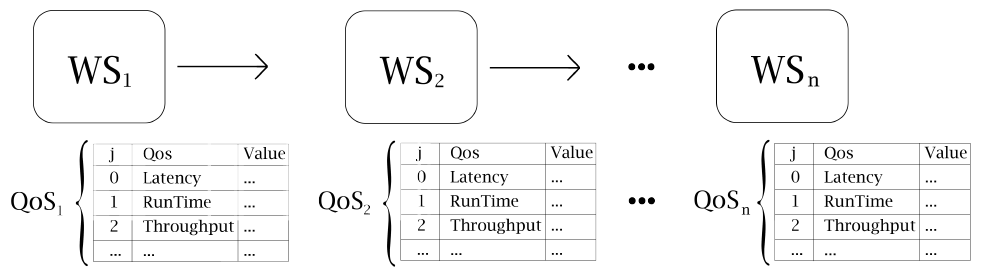
Figure 2. Abstract composition model for the Ar_WSDS